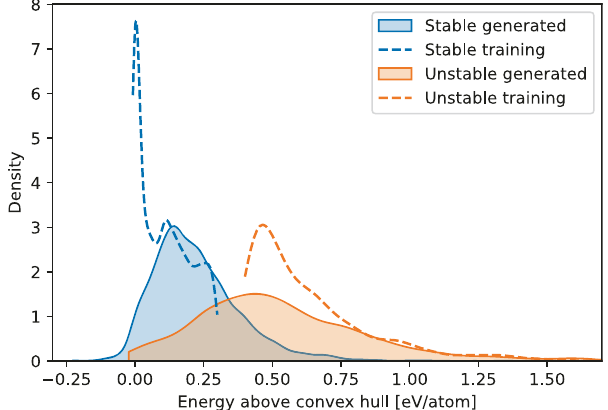
Fig. 5 Kernel density estimate showing the distribution of the convex hull energies for the stable and unstable CDVAE generated dataset. The dashed line shows the distribution of the corresponding training data.